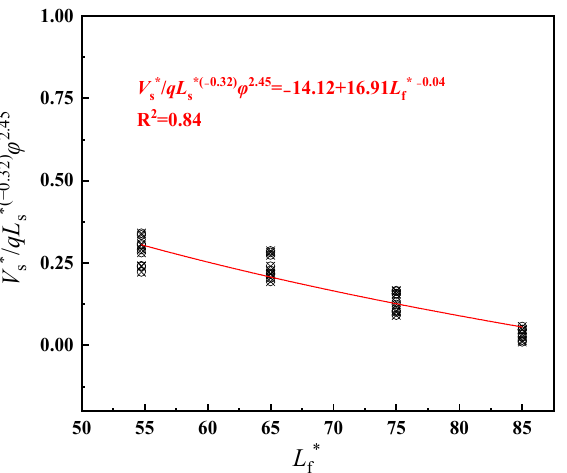
Figure 16. Dimensionless relationship between the inlet air velocity at the shaft outlet and the fire source distance.